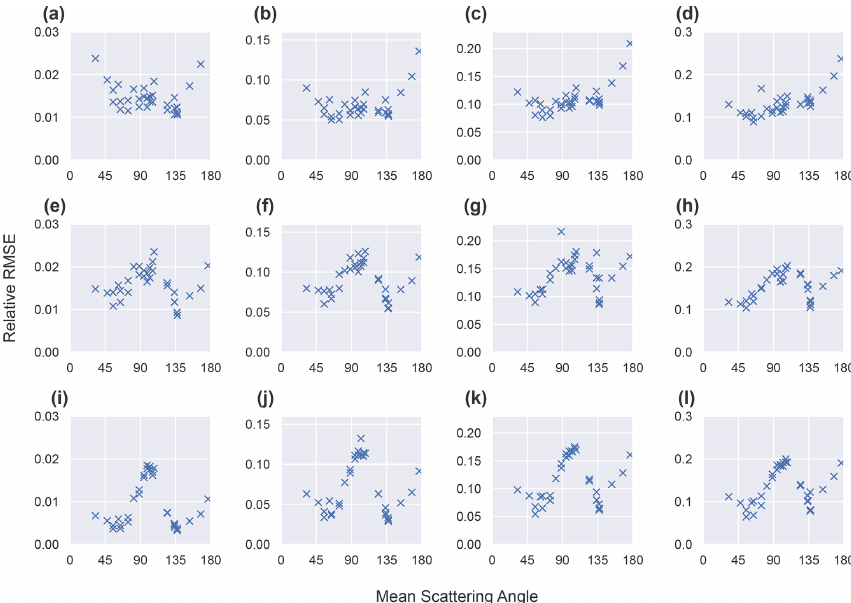
Figure 14. The dependence of the relative RMSE in the approximate Jacobian for each image on the mean scattering angle of each image for cloud base states with conservative scattering and a black surface. As in Figs. 9, 11, and 12, each row corresponds to a base state with different phase function and angular resolution, with isotropic phase function (a, b, c, d) , Mie phase function with high angular resolution (e, f, g, h) , and Mie phase function with low angular resolution (i, j, k, l) . Columns correspond to base states with maximum optical depths of 0.1 (a, e, i) , 5 (b, f, j) , 40 (c, g, k) , and 100 (d, h, l)